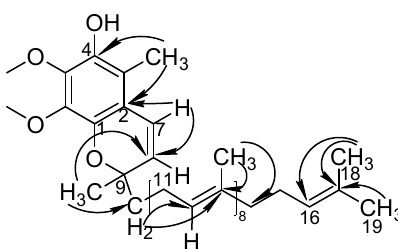
Figure 9. The chemical structure and key HMBC correlations of impurity X. Table 1. C-attribution in the spectrogram of Impurity X.